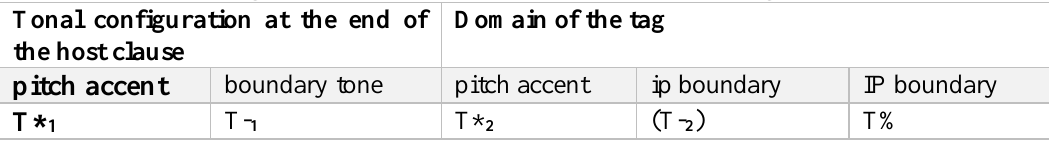
Table 2. Tonal configuration over the end of the host and the tag Tonal configuration at the end of